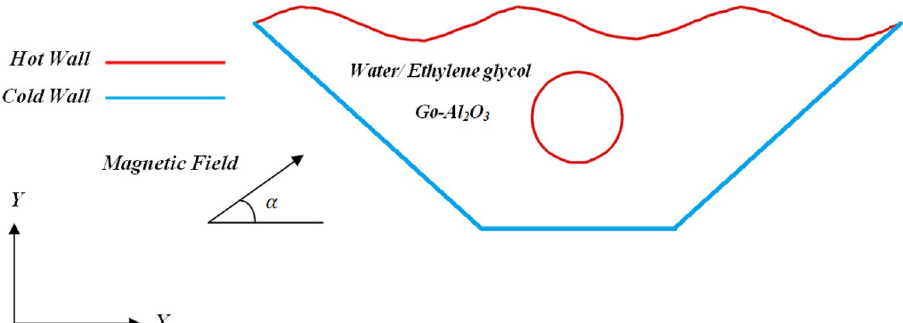
Figure 1. Geometry and boundary